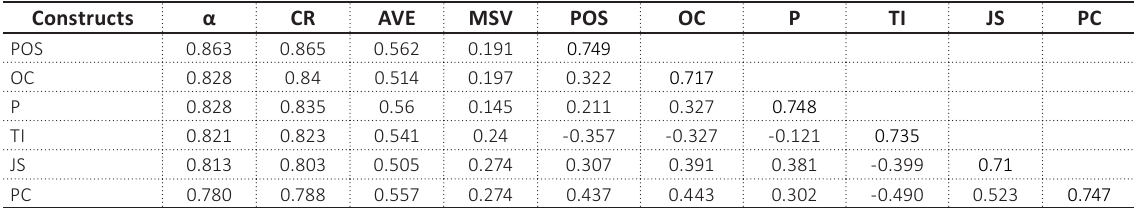
Table 2. Constructs reliability and validity